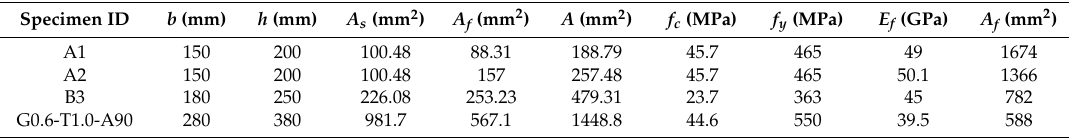
Table 1. Details of beam specimens.